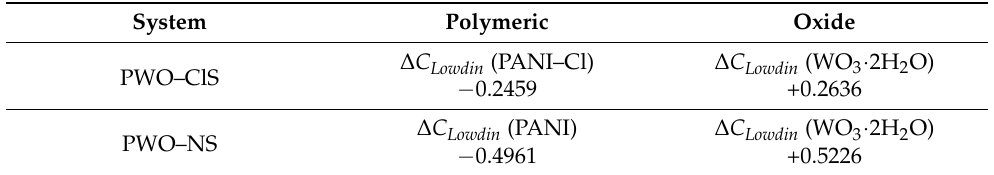
Table 6. Lowdin charge analysis between WO 3 · 2H 2 O and the doped/undoped polymer phase, representing the direction of charge flow in PWO–ClS and PWO–NS